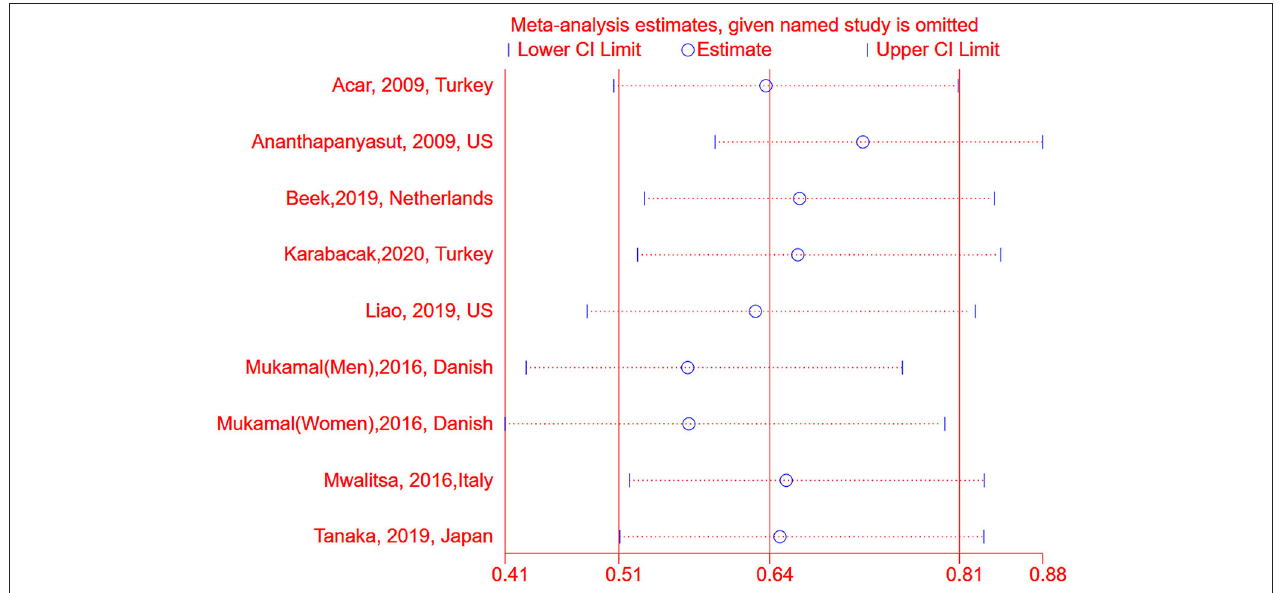
FIGURE 4 | Sensitive analysis between serum albumin and risk of atrial fibrillation by omitting one study at each time. AF, atrial fibrillation; OR, odd risk.